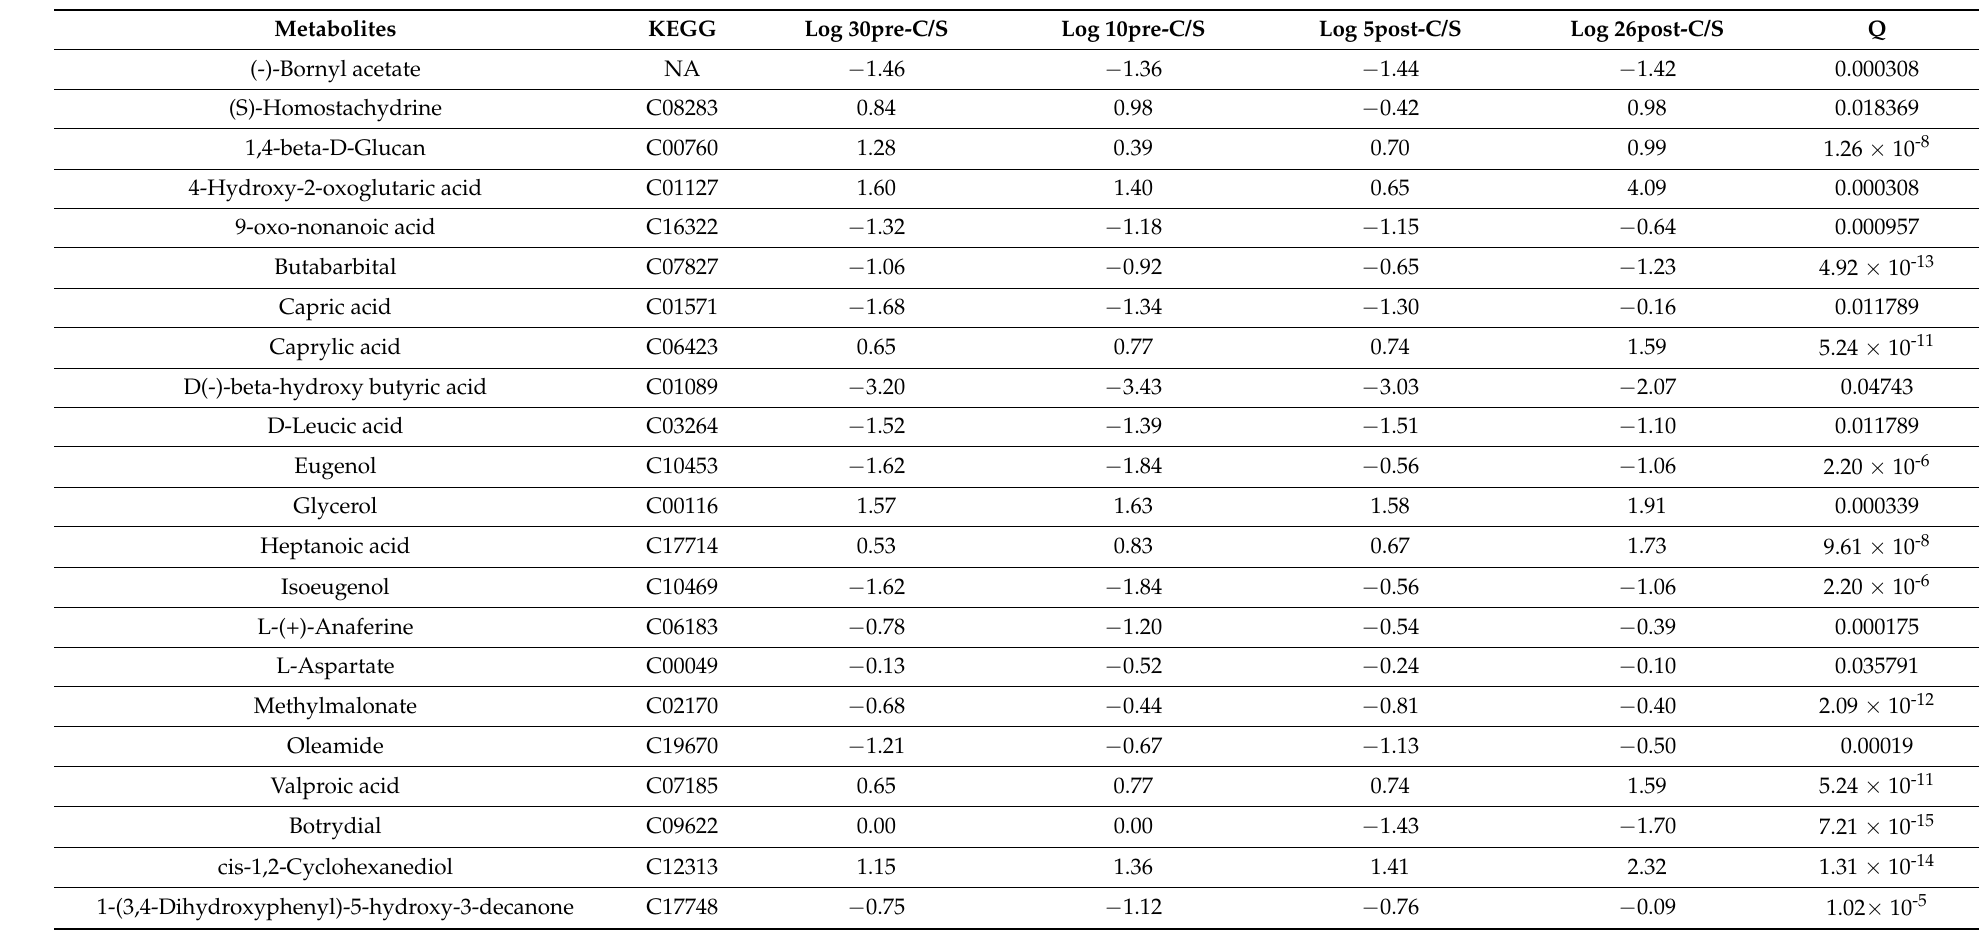
Table 2. List of correlated metabolite features in NEB with log-fc and q